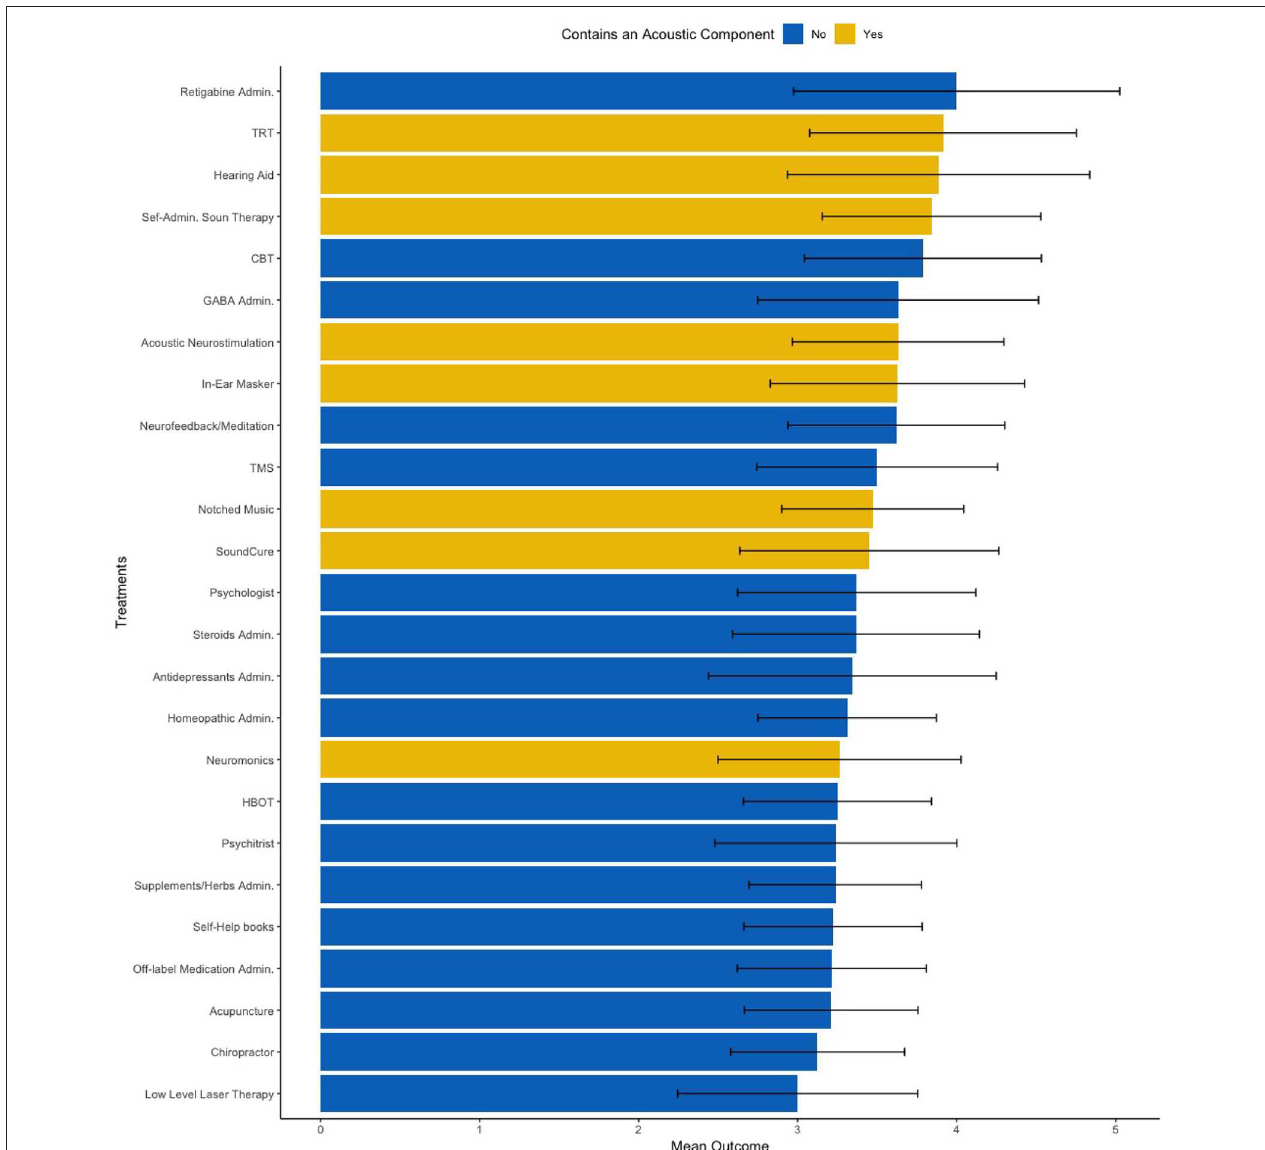
FIGURE 5 | Mean treatment outcomes on a 1–5 Likert scale clustered by treatments with an acoustic component (yellow) and without an acoustic component (blue). Error bar accounts for the standard deviation across all 25 treatments. TRT, Tinnitus Retraining Therapy; CBT, Cognitive Behavior Therapy; TMS, Transcranial Magnetic Stimulation; HBOT, Hyperbaric Oxygen